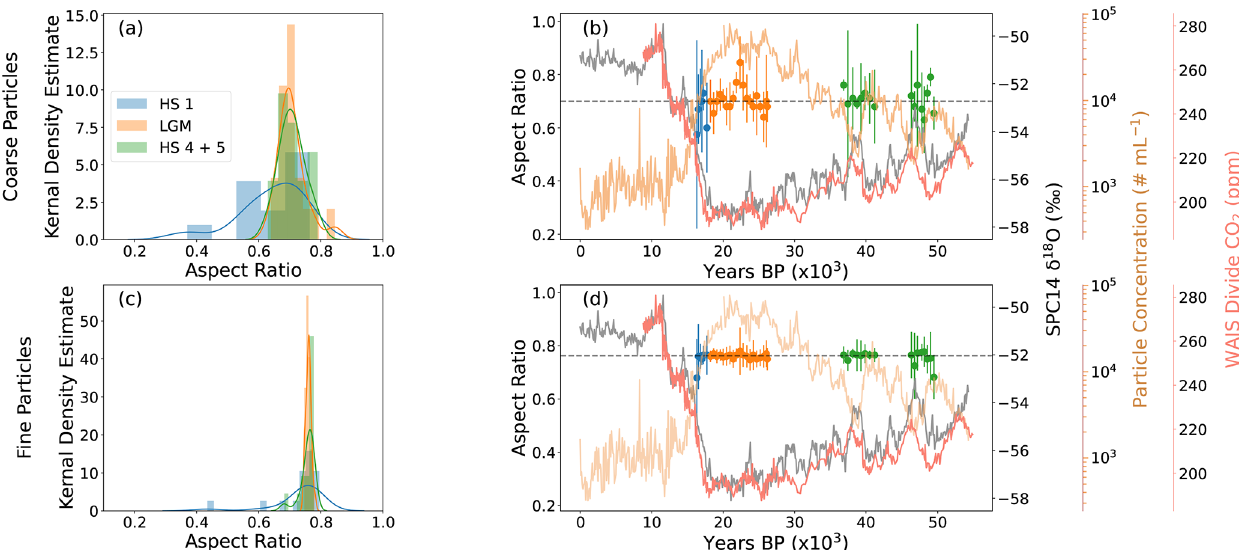
Figure 4. Particle aspect ratio data as a function of aspect ratio (a, c) and time (b, d) . (a, c) Aspect ratio distributions (medians) for HS1, LGM, and HS4 and 5. (b, d) Median aspect ratio values (colors are related to time in panels a and c , respectively) with 2 σ error bars plotted with the SPC14 δ 18 O record (Steig et al., 2021; dark grey), SPC14 particle concentration record (brown), and WAIS Divide CO 2 (Bauska et al., 2021; Marcott et al., 2014; salmon). The top two panels (a, b) show coarse particle ( > 5 . 0µm) data, and panels (c) and (d) show fine particles ( < 5 . 0µm). The variability (2 σ ) increases in samples older than 18ka. Median aspect ratio values are identified by the black dashed line. Results show that aspect ratios are skewed towards more elongate values ( < 1) with fine and coarse aspect ratios of 0 . 76 ± 0 . 5 and 0 . 70 ± 0 . 10 (2 σ ), respectively.